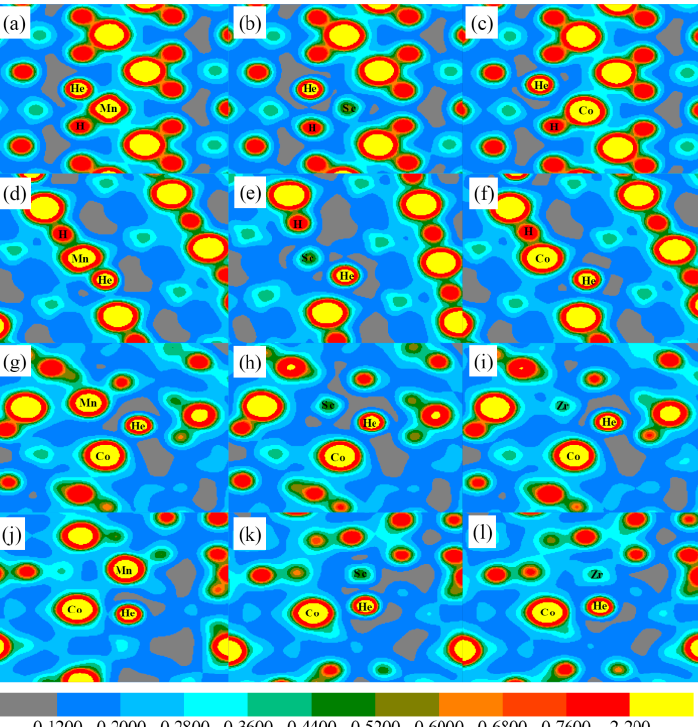
Figure 7. ( a – c ) The charge density map across H, the closest He of Mn, Sc, and Co at Co site, and Mn, Sc, and Co, respectively. ( d – f ) The charge density map across H, the next closest He of Mn, Sc, and Co at Co site, and Mn, Sc, and Co, respectively. ( g – i ) The charge density map across H, the closest He of Mn, Sc, and Zr at Zr site, and Mn, Sc, and Zr, respectively. ( j – l ) The charge density map across H, the next closest He of Mn, Sc, and Zr at Zr site, and Mn, Sc, and Zr, respectively. By carrying out systemical ab inito calculations, we determined the stability of He in ZrCo and the influence of alloying atoms on the stability of He in ZrCo. It was found that the alloying atoms Ti, V, Cr, Mn, Fe, Zn, Nb, Mo, Tc, Ru, Ta, W, Re, and Os replacing Co can increase the substitution energy of H by He at the closest site of alloying atoms (that is, the H site that belongs to H5 in Figure 2). Meanwhile, only the alloying atoms Cr, Mn, Fe, Mo, Tc, Ru, Ta, W, Re, and Os replacing Co can increase the substitution energy of H by He at the next closest site of alloying atoms (that is, the H site that belongs to H6 in Figure 2). In contrast, the influence of the alloying atom substituting Zr site on the substitution energies of H at the closest site of alloying atoms and the next closest site of alloying atoms by He is inconspicuous. All of the substitution energies of H by He at the next closest site of alloying atoms are reduced by alloying atoms at the Zr site, and only Nb, Mo, Ru, Ta, and W increase the substitution energies of H by He at the closest site of alloying atoms. The increase in the substitution energy may suggest that the existence of these alloy atoms is conducive to fix the He atom in ZrCoH 3 . In this way, the He atom is difficult to move, and accumulates to form a bubble and reduce the purity of